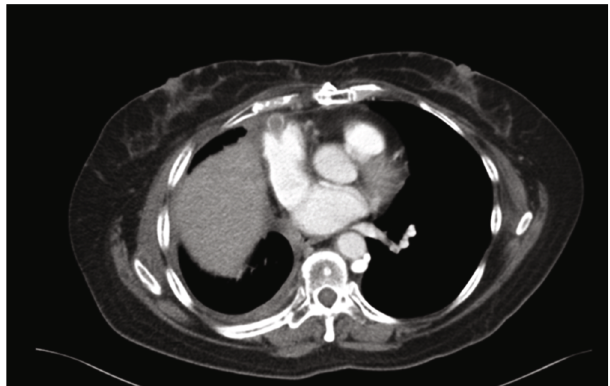
Figure 2: No evidence of breast lesion seen on CECT-TAP in 2016.